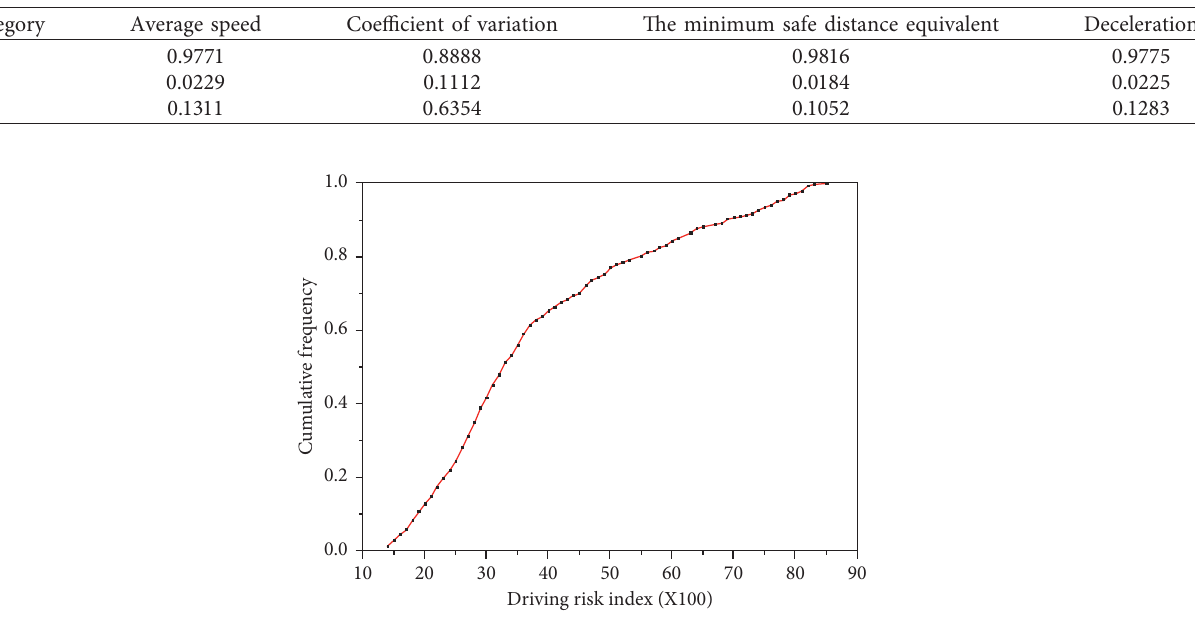
Table 3: Calculation results of the entropy method.